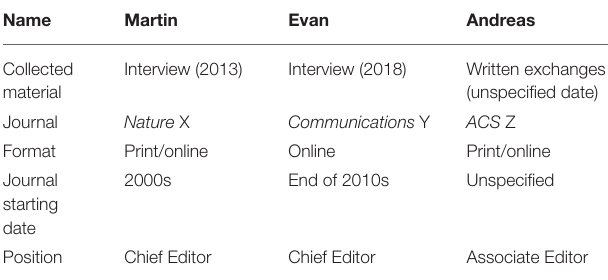
TABLE 2 | Profile of the respondents and their work